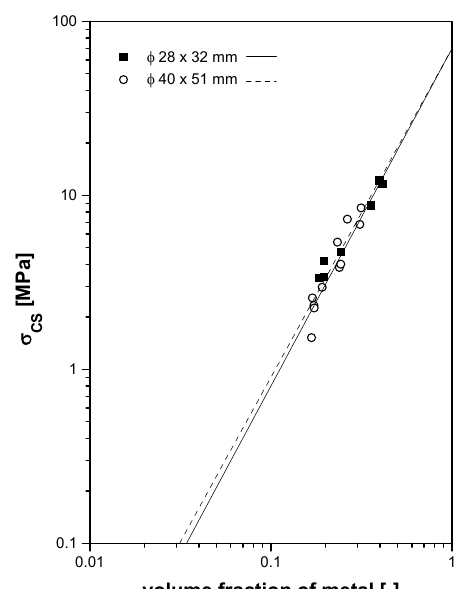
Figure 4: Effect of the pore size and orientation on the compression strength of AlSi11Mg0.6 foam with surface skin  40 x 51 mm 2 at 0.19 volume fraction of metal: vertically oriented pores with apparent diameter of (a) 2.25 mm, (b) 3.03 mm, (c) 5.94 mm and (d) randomly oriented pores with apparent diameter of 4.52 mm.